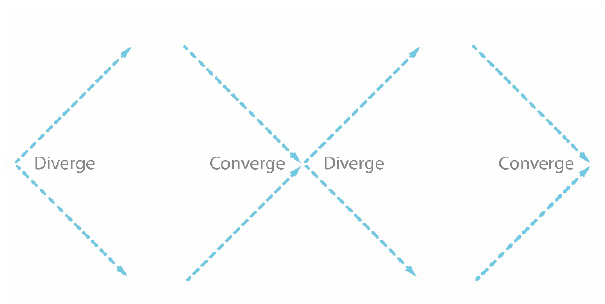
Fig. 2: Diverge & converge: double diamond